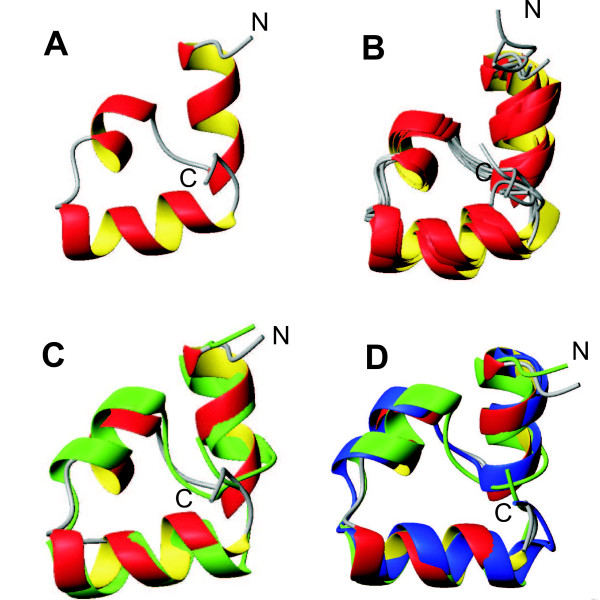
Comparisons of experimental and predicted structures. Experimentally solved solution NMR structure of the VH mutant G34L (deposited in PDB, code 2ppz). (A) Ribbon diagram of the lowest energy structure in terms of total energy. (B) Overlay of 5 final solution structures. (C) Comparison between the model structure (green) and the lowest energy experimental structure. (D) Comparison between the model structure (green), the wild-type X-ray structure (blue) and the lowest energy experimental structure.